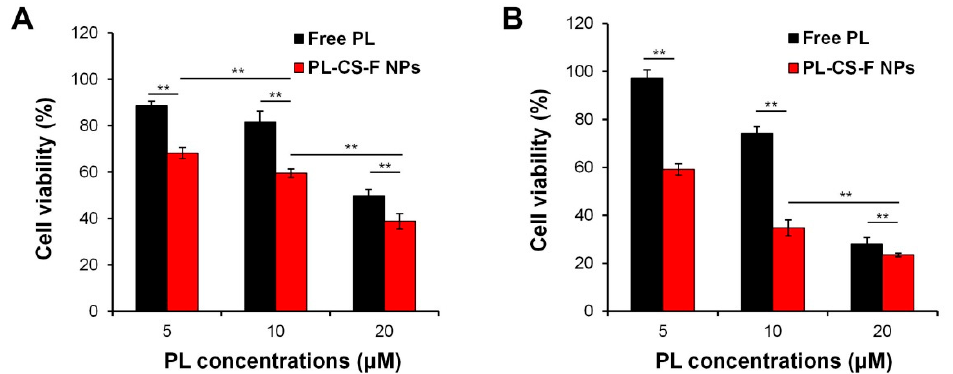
Figure 4. Cytotoxicity evaluation of free PL and PL-CS–F NPs against ( A ) hDFB and ( B ) PC-3 cells at different concentrations of PL (** p < 0.01).